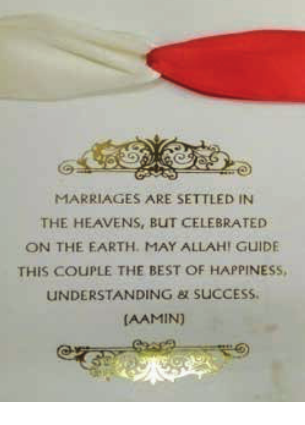
Figure 1 : Opening with Quranic verse Another less frequent opening form was quote based on prophetic invocations as 16% of the data showed.